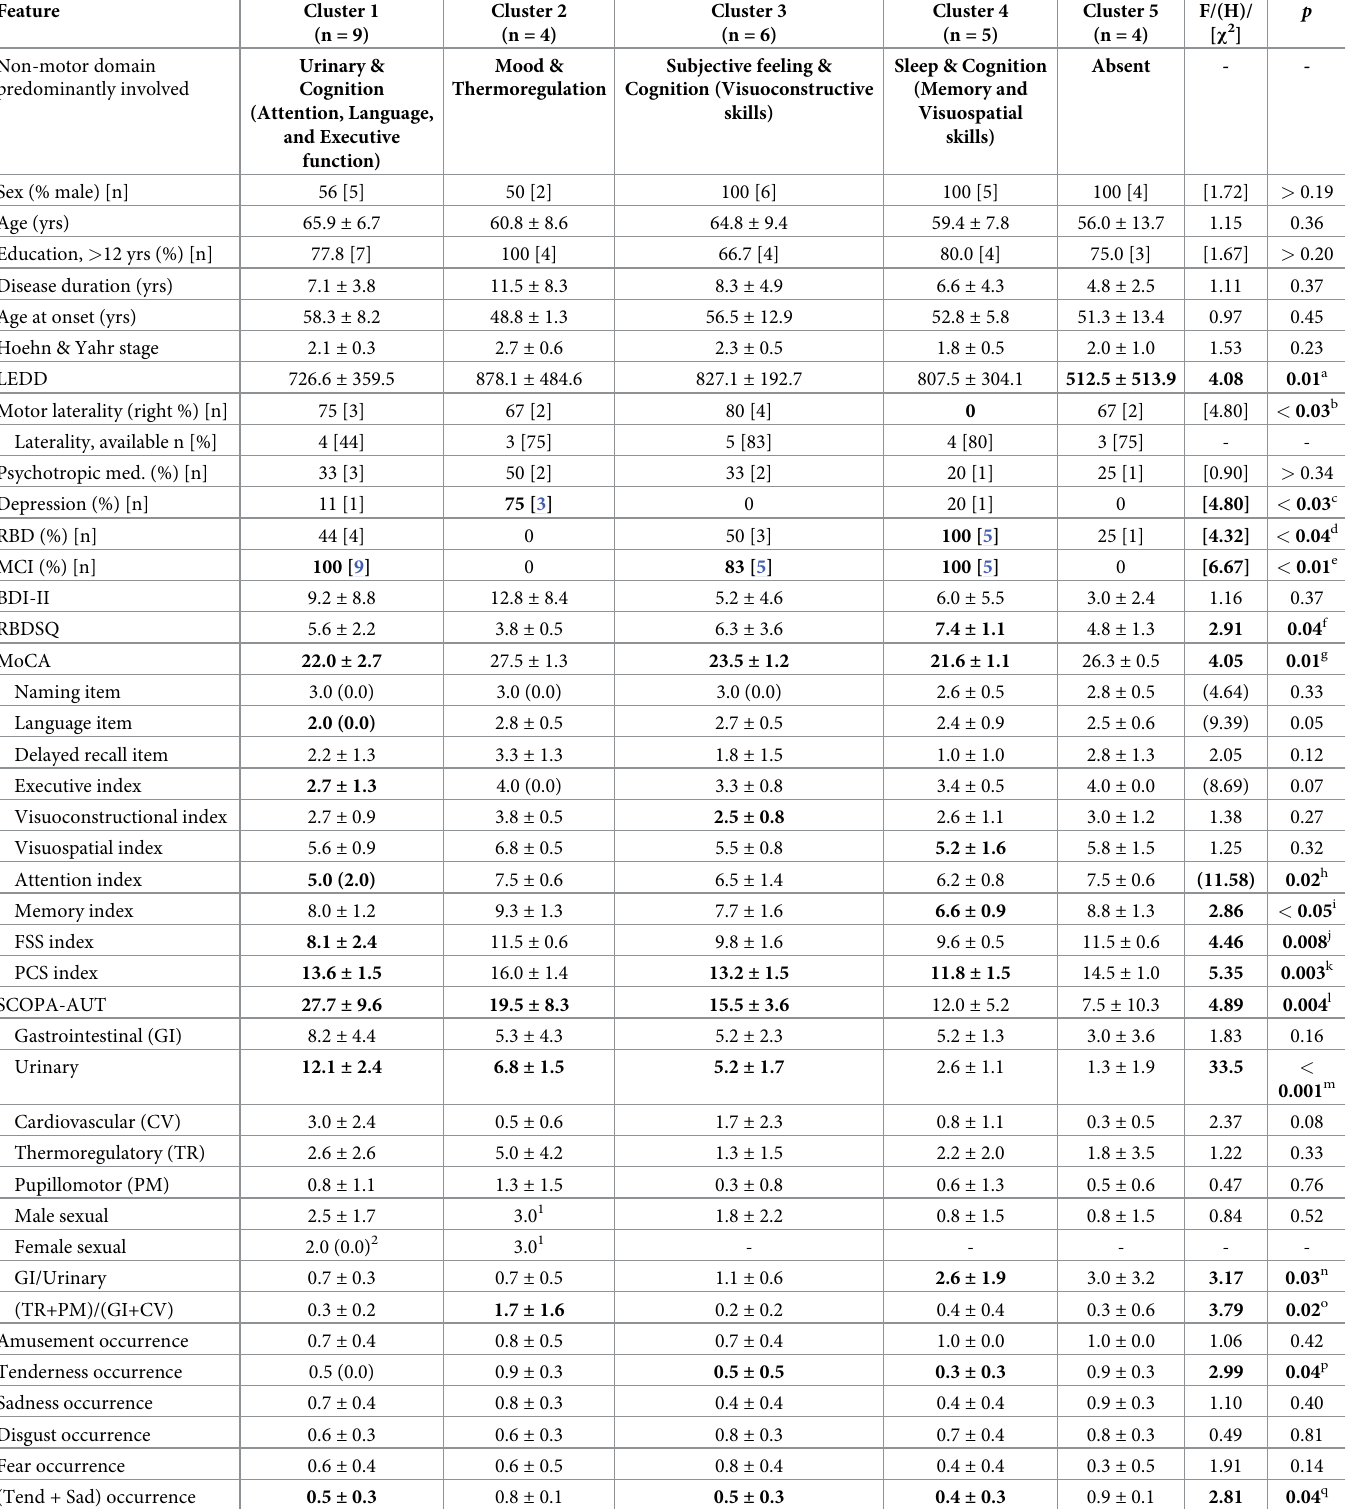
Table 5. Clusters of Parkinson’s disease patients profiled according to relevant non-motor